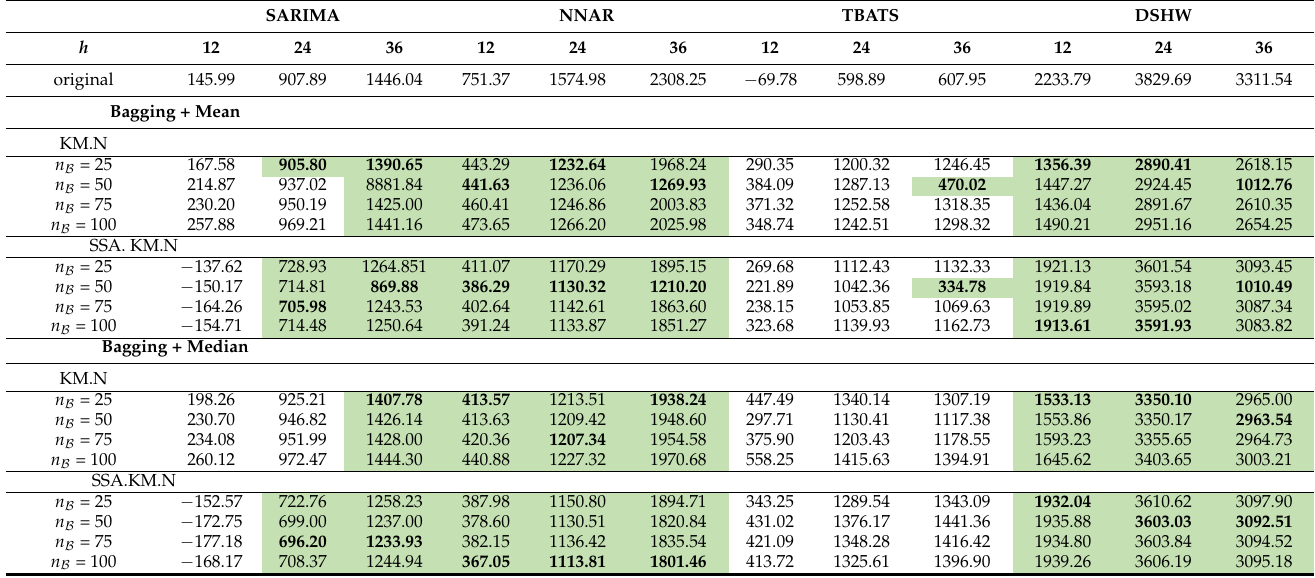
Table 7. MBEs of h -step ahead forecast for the first data set obtained by SARIMA, NNAR, TBATS, and DSHW models.